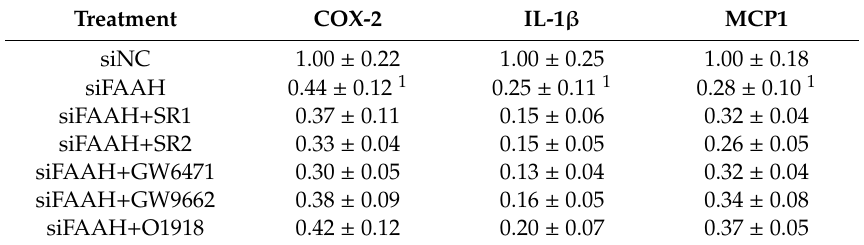
Table 3. E ff ect of CB receptor or PPAR antagonist in LPS-activated FAAH knockdown cells.